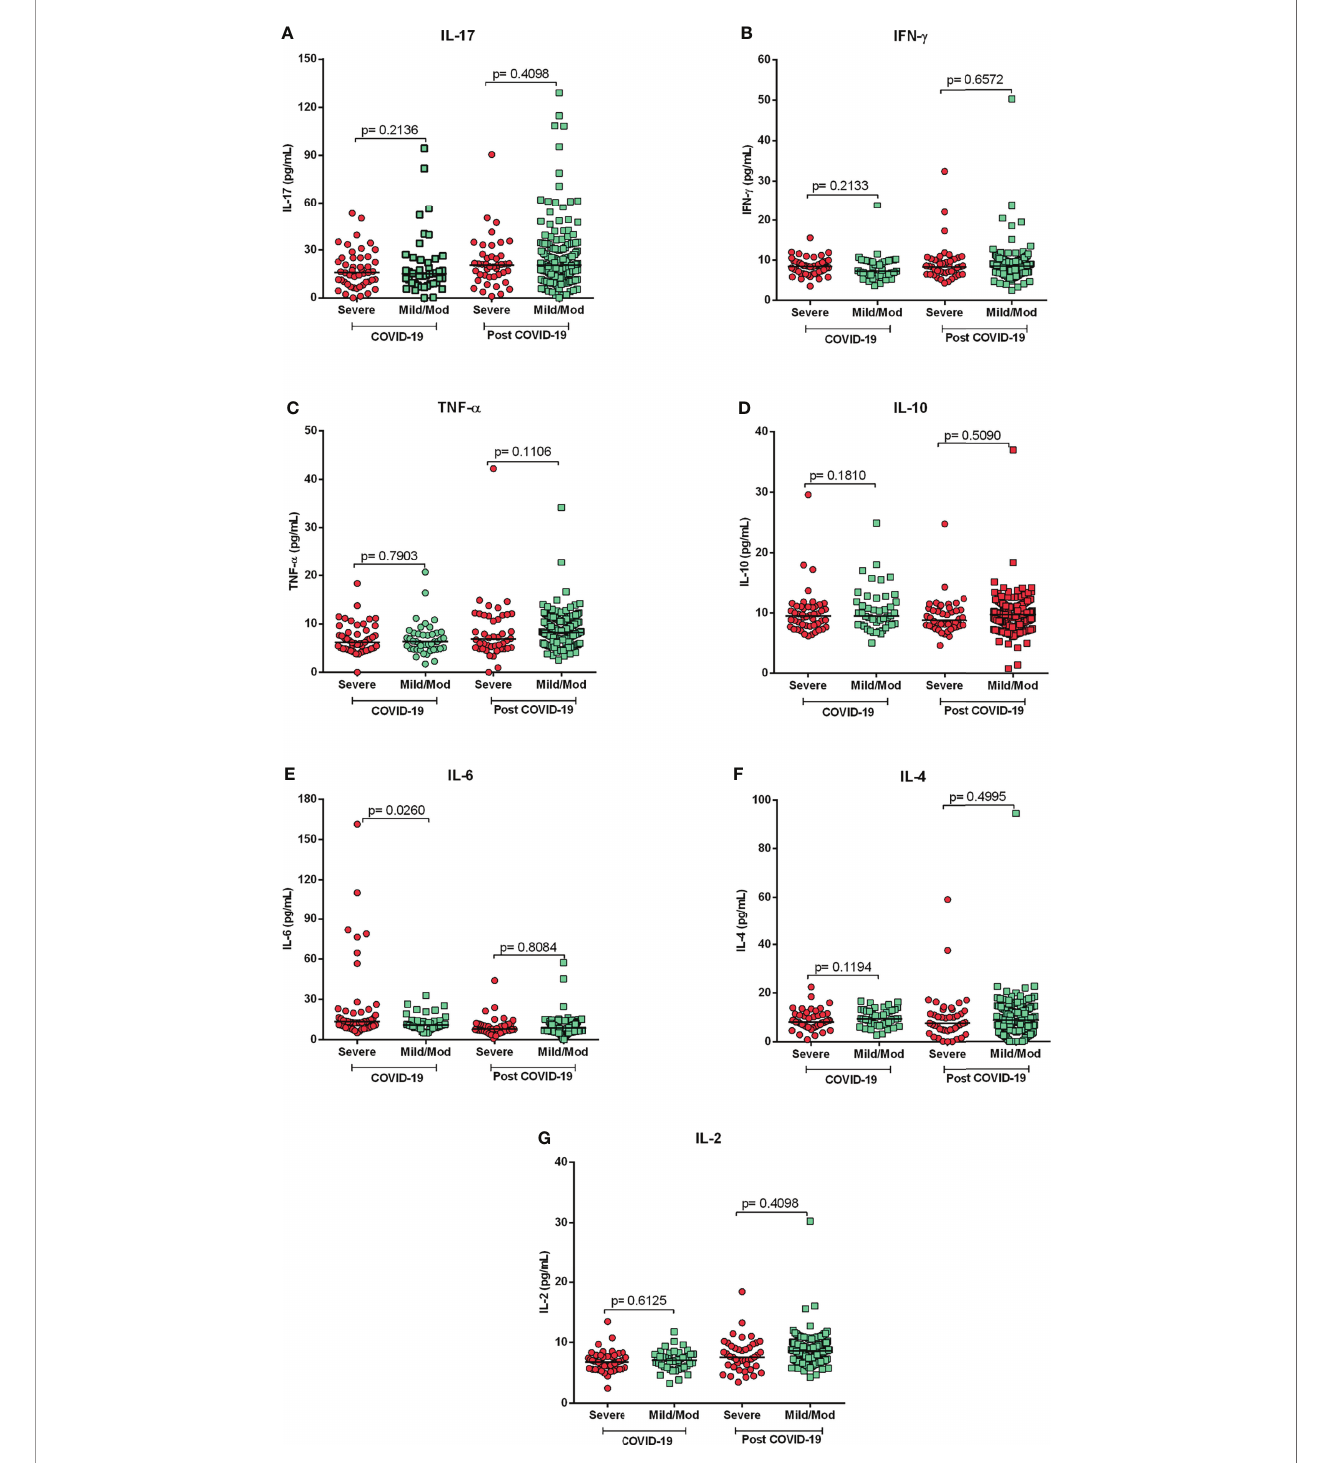
FIGURE 2 | Cytokine pro fi les in acute and post-COVID-19 syndrome. Comparison of cytokine levels of patients with severe and mild/moderate COVID-19 and post- COVID-19. Mild/Mod: mild/moderate. Mann-Whitney Test. (A) IL-17, (B) IFN-y, (C) TNF-a, (D) IL-10, (E) IL-6, (F) IL-4 and (G)